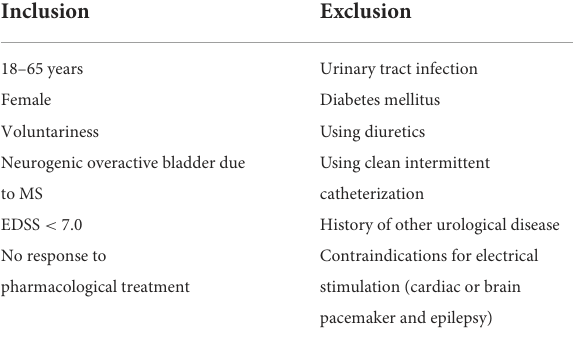
TABLE 1 Inclusion and exclusion